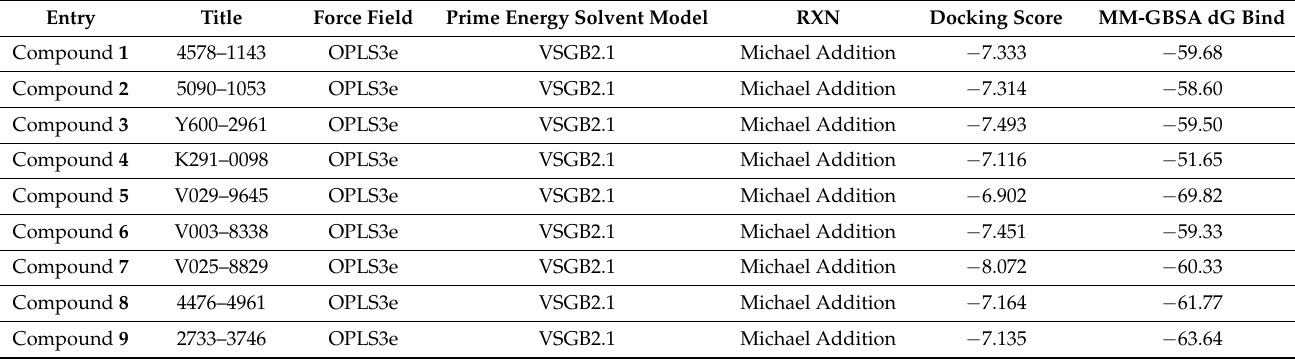
Figure 3. A description of our workflow and descriptions of the selected molecules. ( a ) Hybrid workflow coupling non-covalent and covalent screening processes for XPO1. ( b ) Characteristics of the final selected molecules. Table 1. Docking score data for selected small